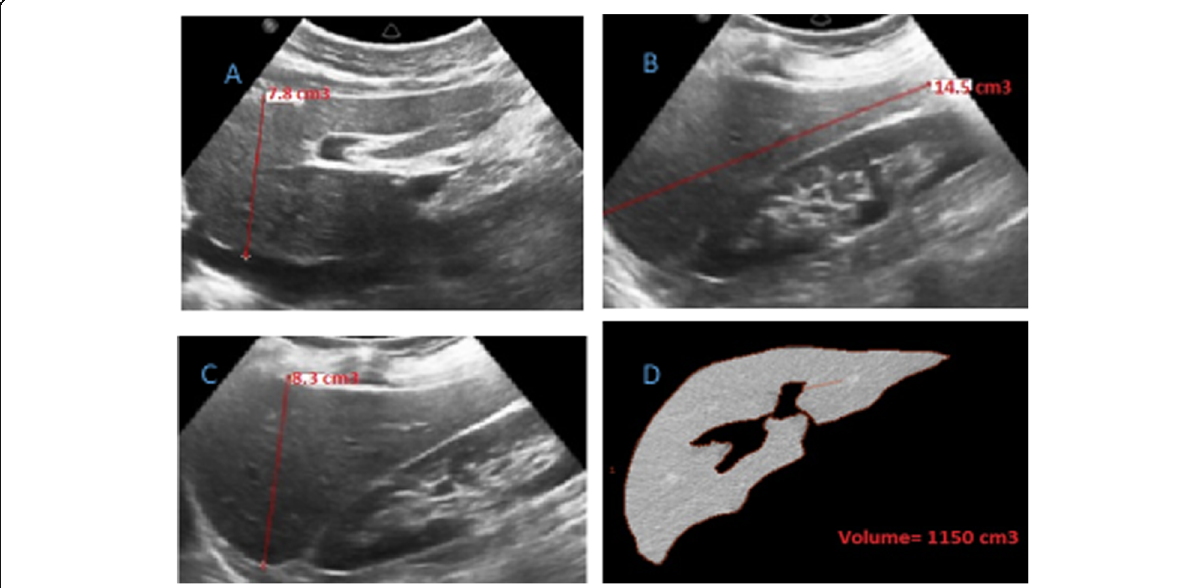
Fig. 3 Female patient, 50 years old. a Image 1 represents left lobe of the liver (7.8 cm). b Image 2 represents right lobe of the liver (14.5 cm). c Image 3 represents right lobe of the liver (8.3 cm). Liver volume (cm3) = 343.71 + (0.84 × ABC) = 343.71 + (0.84 × 7.8 × 14.5 × 8.3) = 1132.2 cm 3 . d Semi-automated CT volumetry for the same case with liver volume was 1150 cm